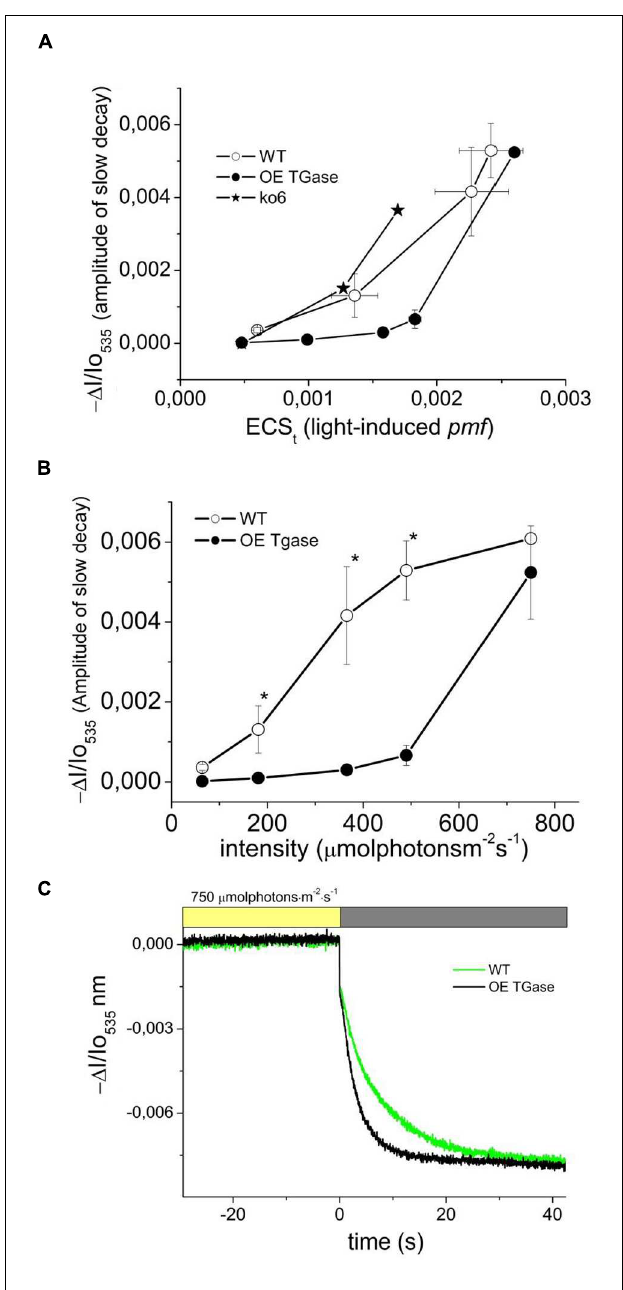
FIGURE 7 | Threshold of activation for the light scattering which is an index of photoprotection activation. (A) Proton motive force probed by the rapid absorbance changes at 535 nm and energization of thylakoid membranes for intact WT and OE TGase plants probed by the amplitude of the slow absorbance changes at 535 nm. For comparison we plot data from experiments with antenna mutants under similar conditions (trace ko6). ko6 is a deletion mutant of CP24. (B) Light scattering as a function of light intensity. The results from absorbance spectroscopy are in line with the results from fluorescence spectroscopy ( Figure 3B ). Membrane energization (in terms of 535 nm amplitude) has a higher threshold of activation in OE TGase. (C) Typical absorbance changes after cessation of actinic light (750 µ mol photons m − 2 s − 1 ) and decay of the steady state signal in WT and OE TGase. Thus at high light intensities we have similar amplitude of scattering changes, but OE TGase show much more rapid